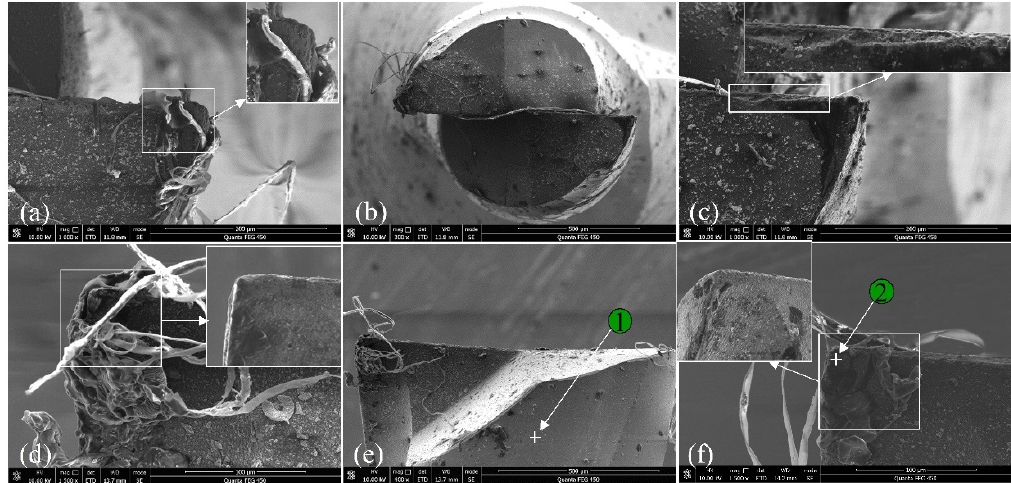
Figure 8. The tool microstructure after milling 300 mm for BMG workpiece. ( a ) Corner 1 bottom view; ( b ) macro bottom view; ( c ) corner 2 bottom view; ( d ) corner 1 side view; ( e ) macro side view; ( f ) corner 2 side view.